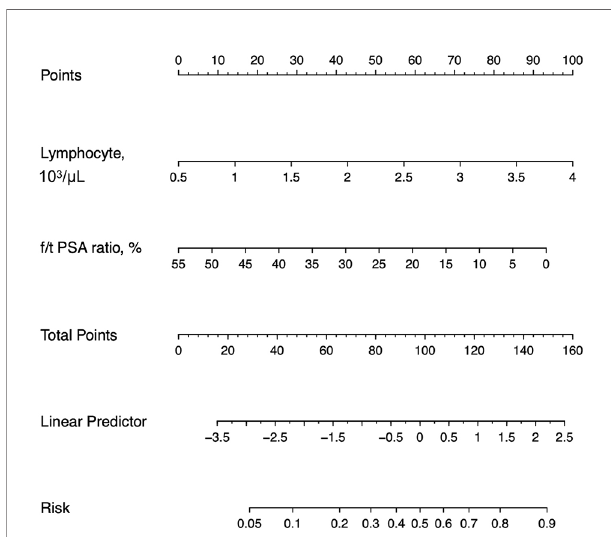
FIGURE 4 | Nomograms for the laboratory model. f/t PSA ratio = free to total prostate-speci fi c antigen ratio.